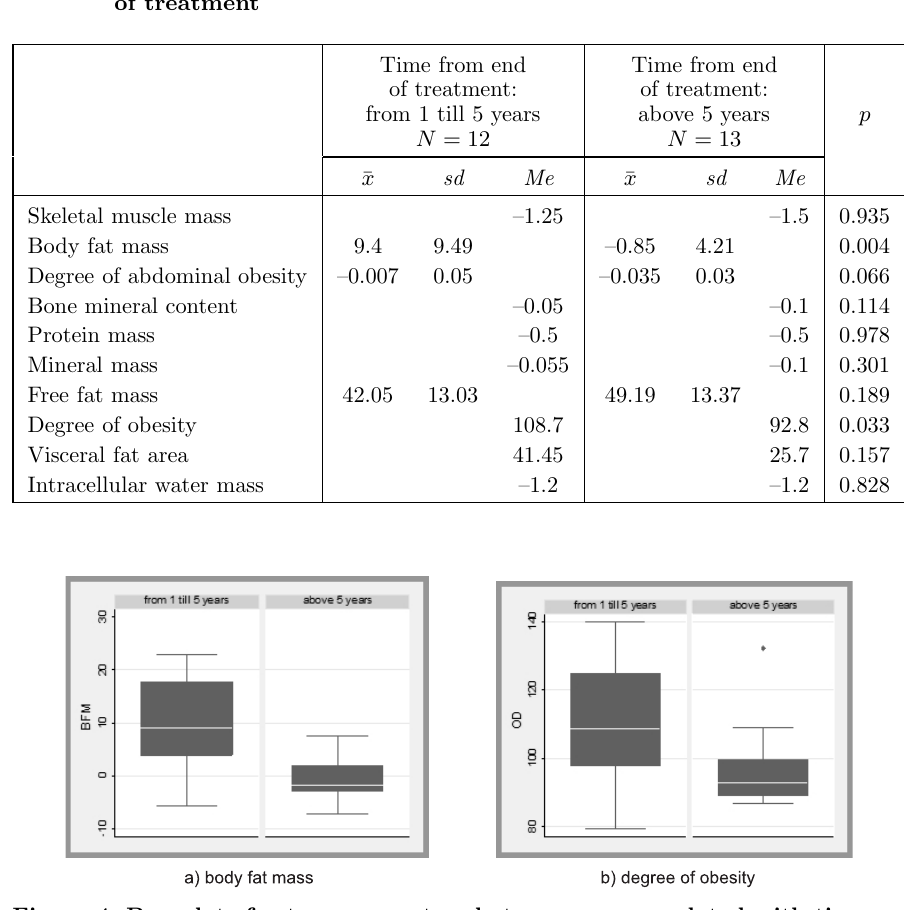
Figure 4. Box plots for two parameters between groups related with time from end of